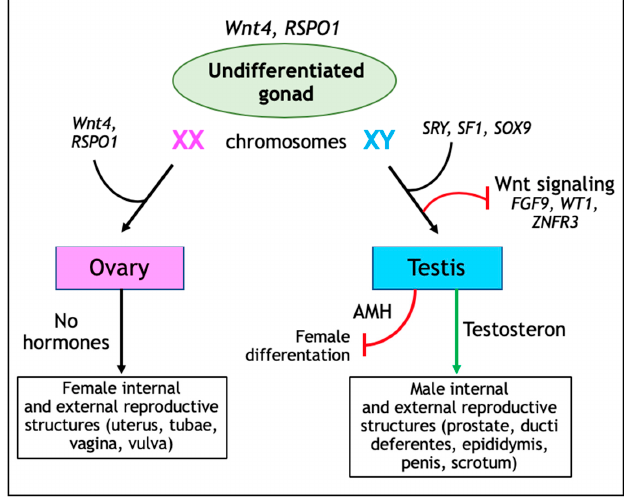
Figure 2. Schematic view of sex determination. In the undifferentiated gonad both Wnt4 and RSPO1 (R-spondin 1) are important regulators in particular for the proliferation of the coelomic epithelium. In XX gonads, expression of Wnt4, and RSPO1 leads to ovarian differentiation and oogenesis as they suppress Sox9 expression, stimulate granulosa cell differentiation, and promote female sexual development by sustaining Müllerian duct differentiation. In XY gonads male reproductive organs are determined by the expression of sex-determining region Y (SRY) together with Splicing factor 1 (SF1) leading to upregulation of Sox9 gene expression. In addition, Fibroblast Growth Factor 9 (FGF9), Wilms Tumor 1 (WT1), and Zinc Finger 3 (ZNFR3) inhibit the pro-ovarian Wnt signaling pathway. Also, anti-Müllerian hormone (AMH) prevents the development of the Müllerian duct into female reproductive